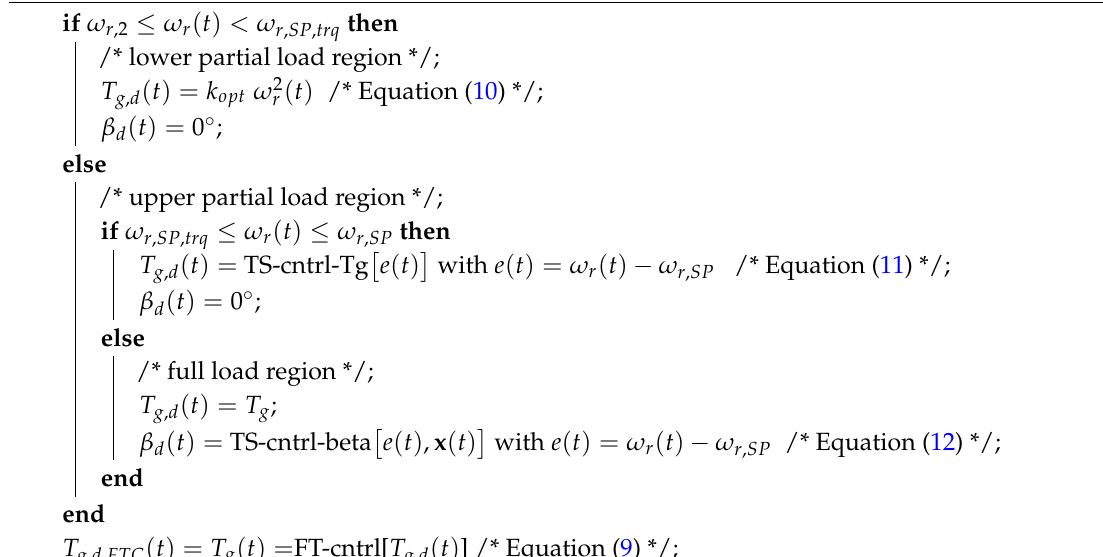
Algorithm 1: FTC hybrid wind turbine control